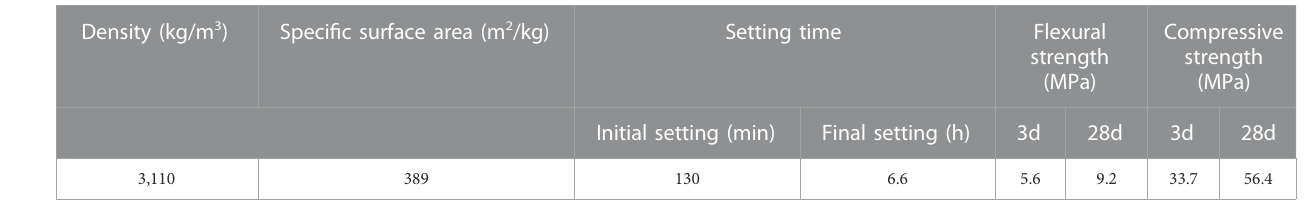
TABLE 1 Physical properties of P.O42.5 ordinary Portland cement.